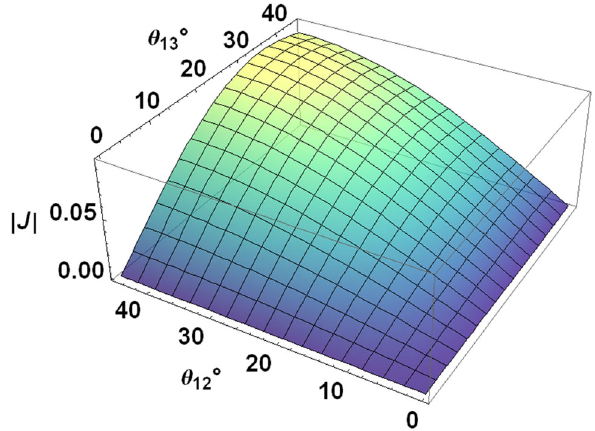
Fig. 5 Dependence of the absolute value of the Jarlskog invariant J on θ 12 and θ 13 for neutrinos in CBM parameterization